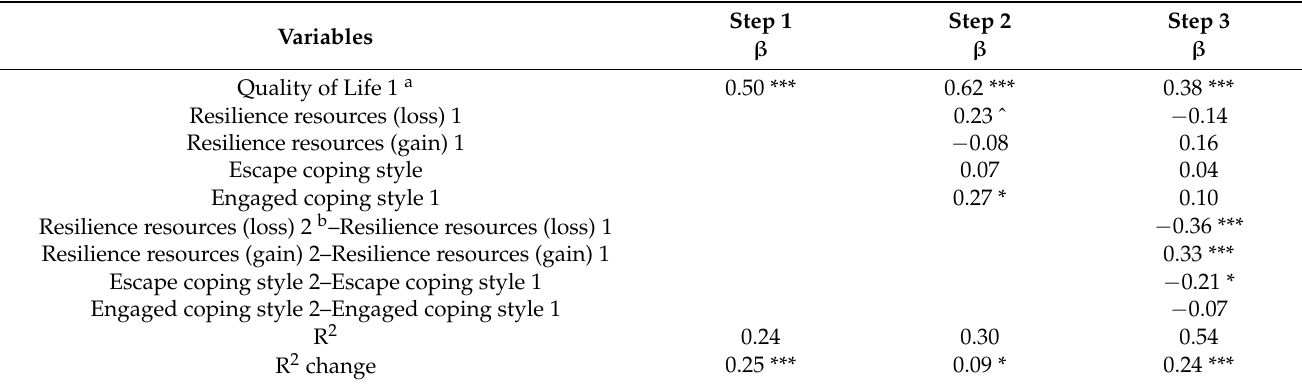
Table 2. Results of Hierarchical Multiple Regression Analysis for the Second QoL